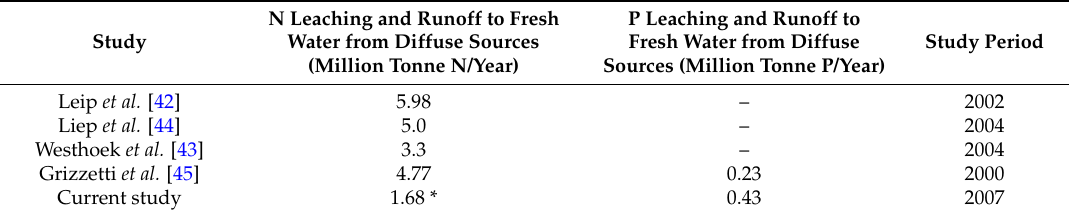
Table 5. Comparison of the Estimated Overall Diffuse N Load from the EU-27 1 S Croplands to Fresh Water with the Results from Previous